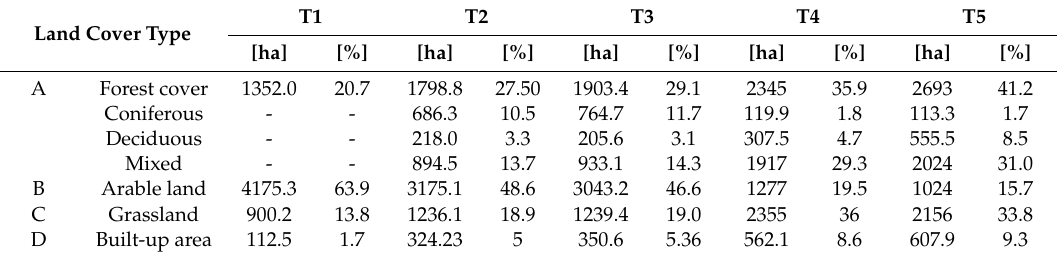
Table 3. Land cover change (1824–2016).